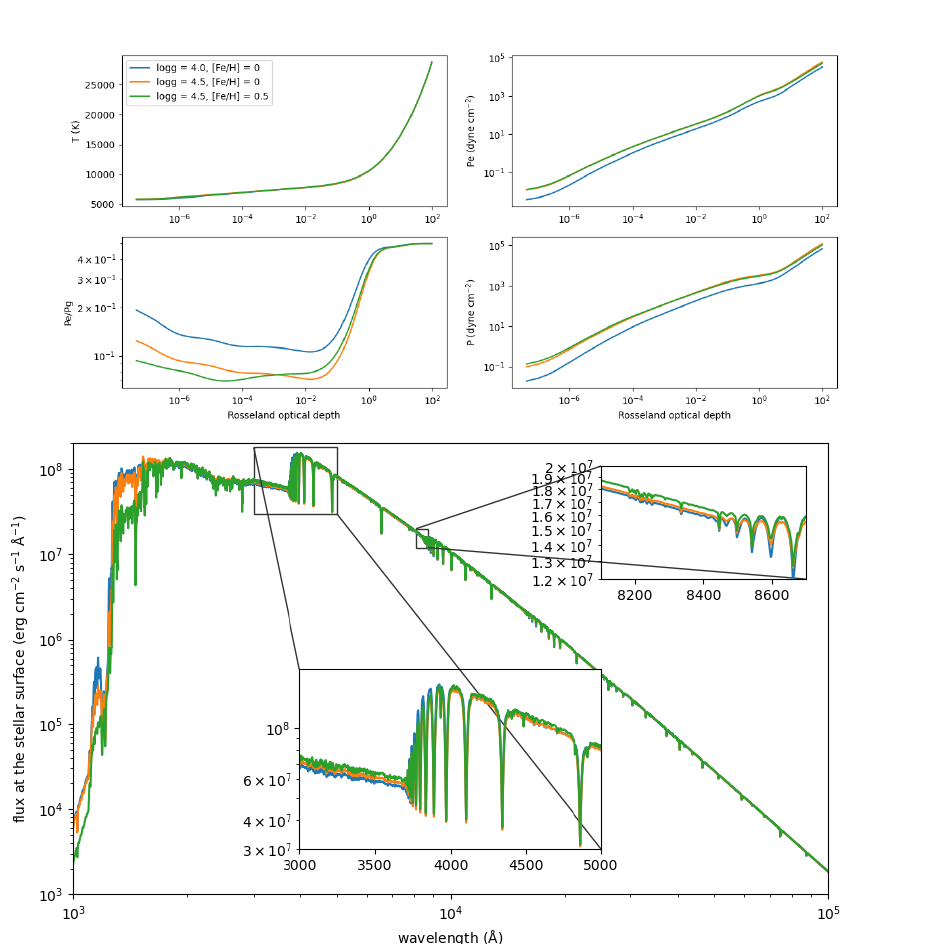
Figure 8. ( Upper panel ) Run of various thermodynamical quantities (clockwise: temperature, elec- tron pressure ( Pe ), gas pressure ( P ), and their ratio ( Pe / P )) with the Rosseland mean opacity for model atmospheres for an A-type star ( T eff = 9750 K). ( Lower panel ) Predicted emergent flux at the atmospheric surface for the models in the upper